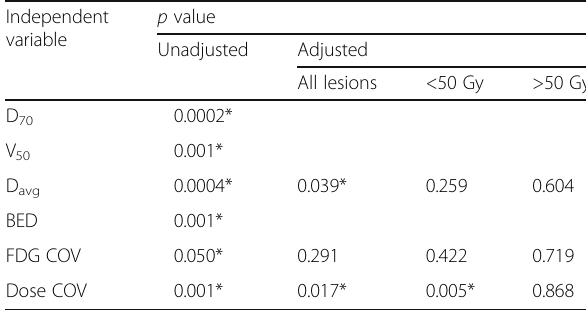
Table 4 Univariate (unadjusted) logistic regression and multivariate (adjusted) backward stepwise likelihood ratio regression of factors associated with significant lesional response